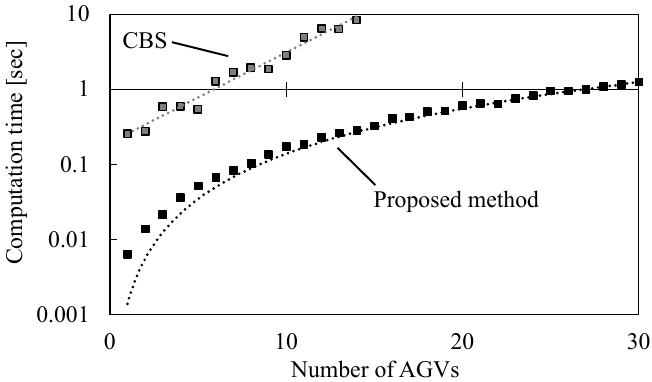
Figure 18. Computation time with respect to the number of AGVs A